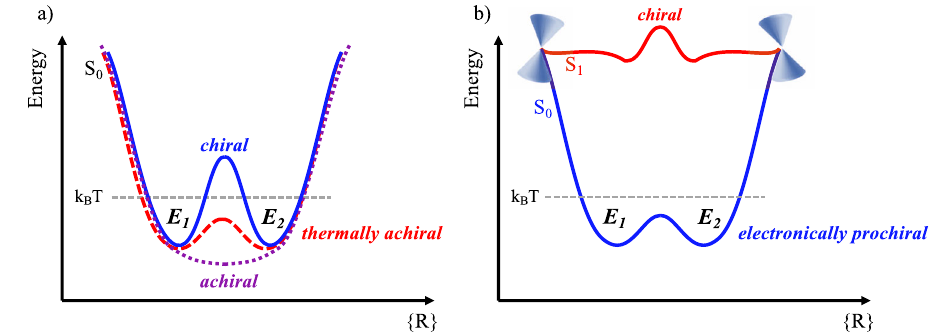
Fig. 1 Schematic potential energy surfaces (PESs) for chiral and achiral molecules. a A barrier separates two minima corresponding to the two enantiomers ( E 1 and E 2 ): if the interconversion barrier is much higher than the thermal energy (k B T), the molecule is chiral, otherwise rapid interconversion between the two enantiomeric con fi gurations takes place making them inseparable (thermally achiral molecules). b PESs for electronically prochiral molecules which can be converted from achiral to chiral by electronic excitation. The example here shows a case where the molecule is thermally achiral on the ground state, but a similar scenario is also possible where the molecule is truly achiral on the ground